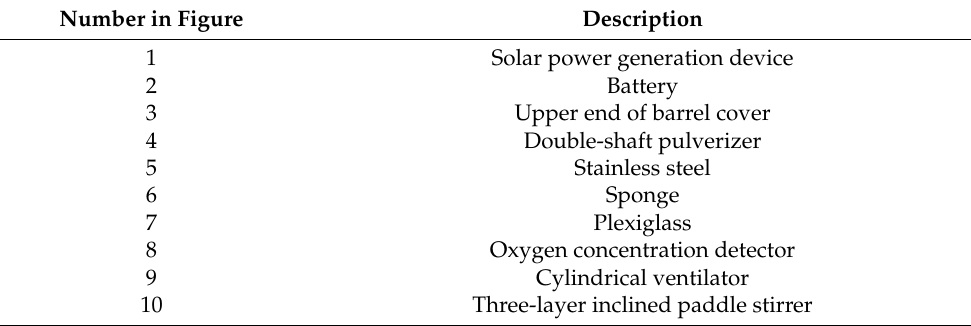
Table A7. An aerobic fully automated composter from CN209555095U